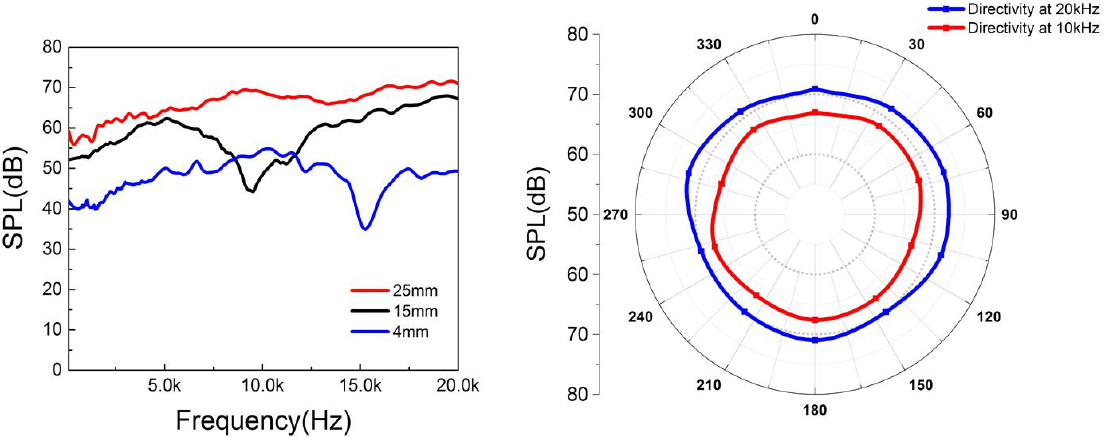
Figure 5. Performance testing of the 360-degree thermal sound source. ( a ) The output sound pressure level vs. the frequency. ( b ) The directivity of the thermal sound source.